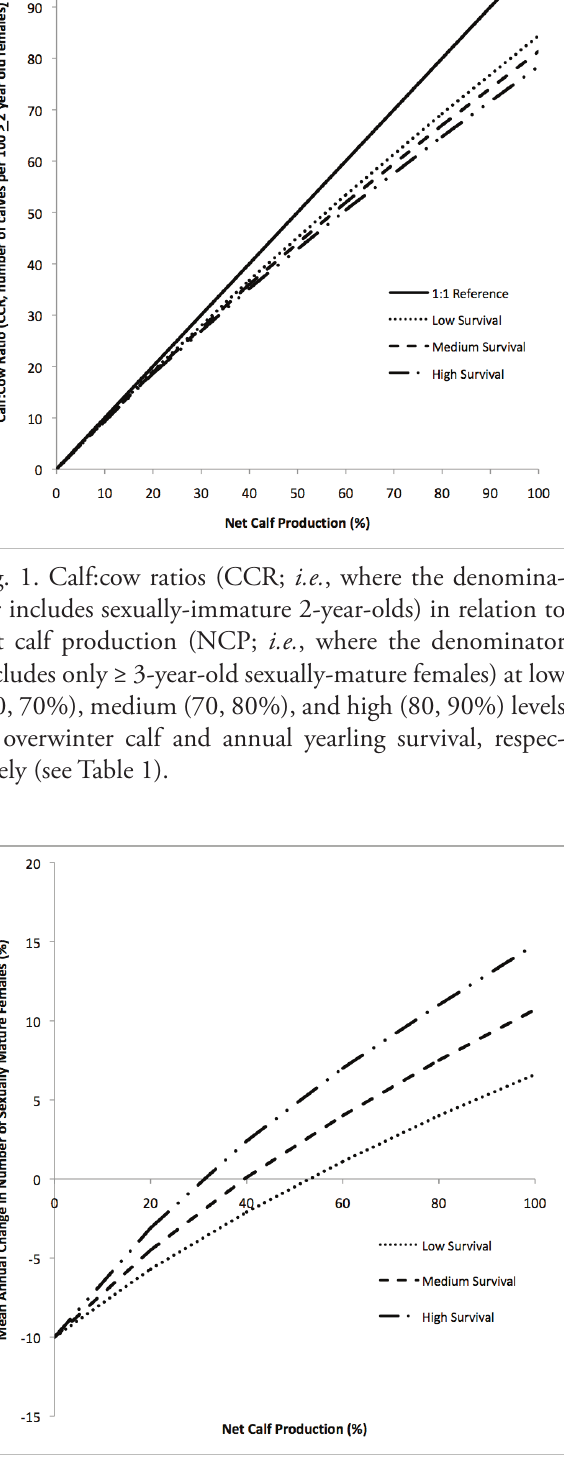
Fig. 2. Mean annual rates of change in the number of sex- ually-mature females in relation to net calf production at low (60, 70%), medium (70, 80%), and high (80, 90%) levels of overwinter calf and annual yearling survival, re- spectively (see Table